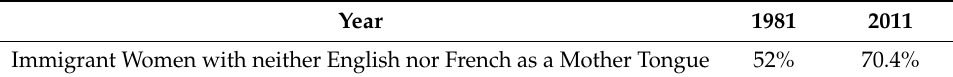
Table 2. This degree of language diversity is related to a decreasing proportion of immigrants landing in Canada from Europe (Hudon 2015). Table 2. Immigrant Women with neither English nor French as a Mother Tongue (Hudon